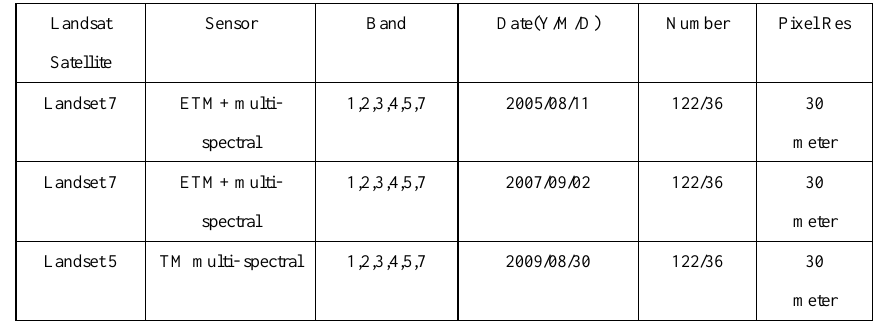
Table 1. Main characteristics for the selection of RS data source in study area Fig.3 images of 2005,2007,2009 at the band 543-RGB.